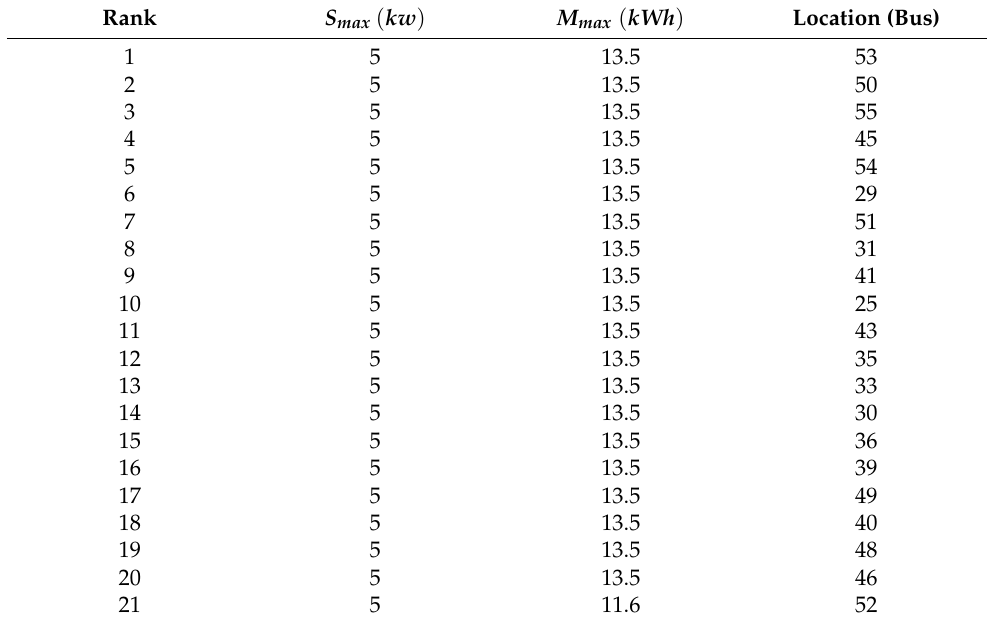
Table 2. The ranks, capacities, and locations of the BESS in the network.